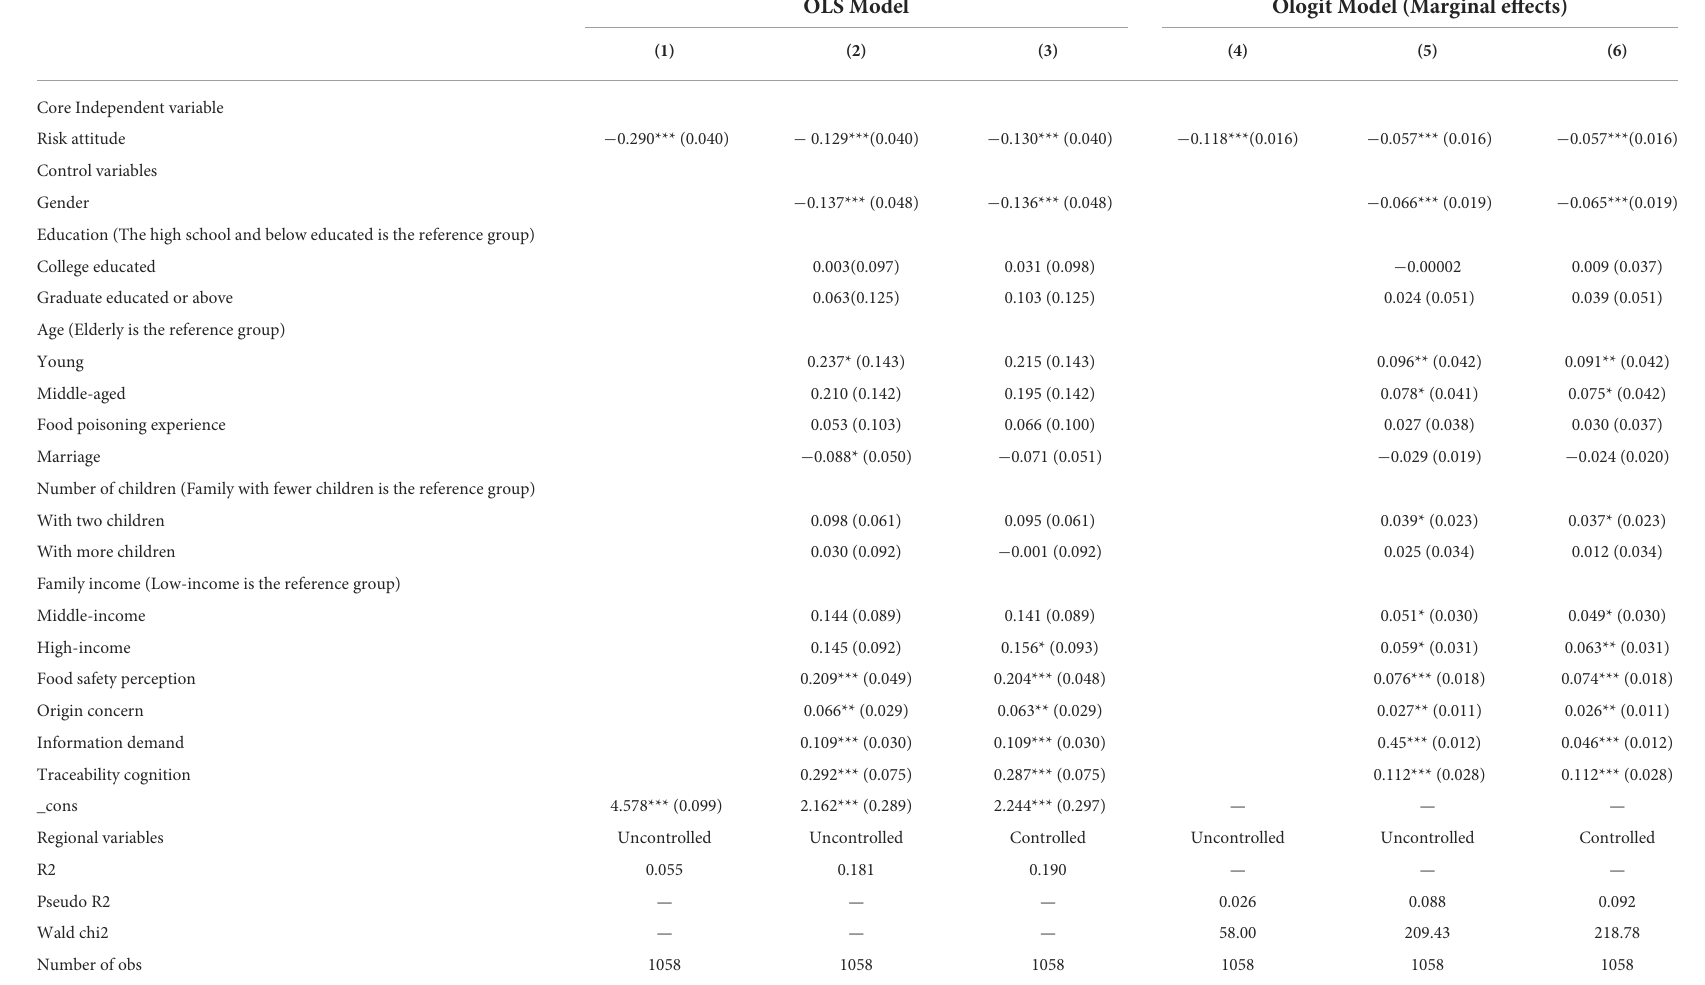
TABLE 2 Impact of food control risk attitude on consumer information seeking.